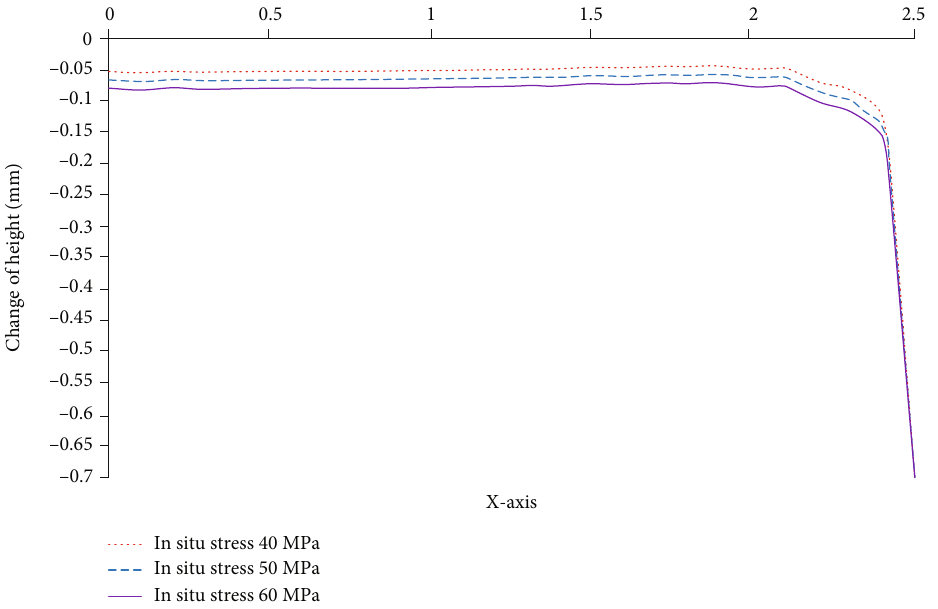
Figure 27: The change value of proppant height under di ff erent in situ stresses (elastic modulus 40 GPa).